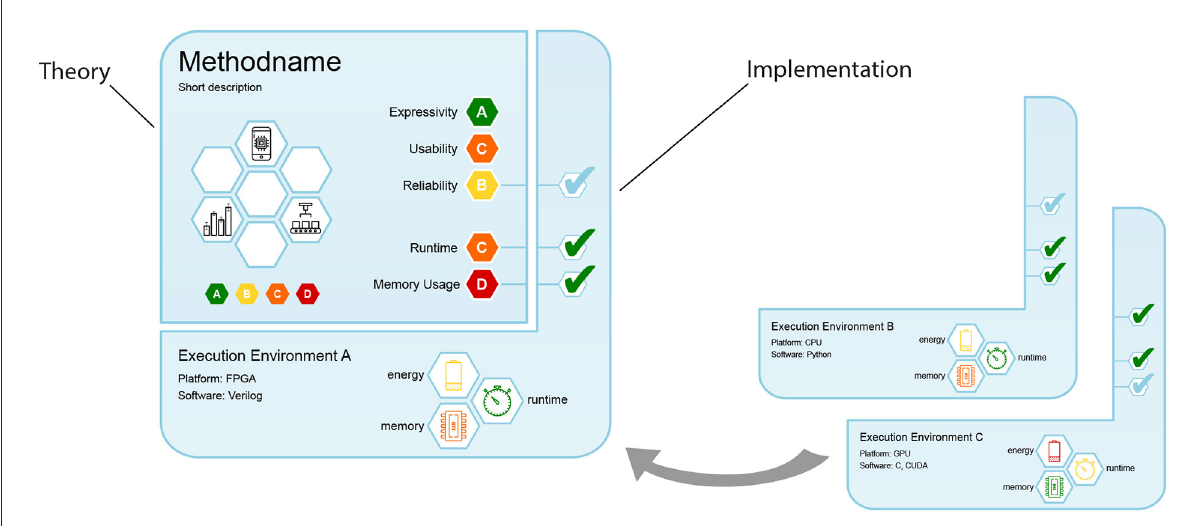
FIGURE2 Design of machine learning care labels, consisting of theory and implementation